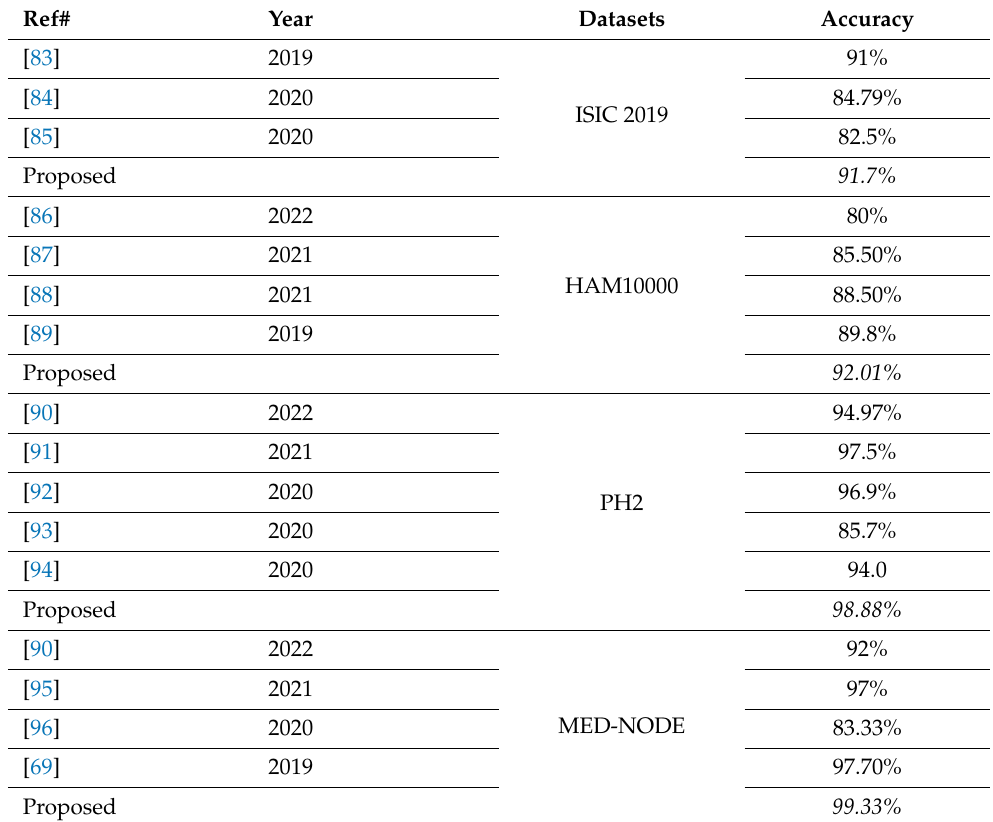
Table 12. Comparisons of proposed classification method outcomes with existing